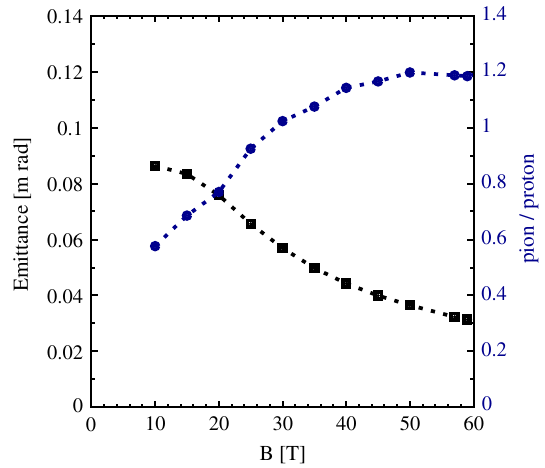
FIG. 5. The transverse emittance of secondary pions at the end of the target is stabilized by the target solenoid field as predicted by the analytic form. The number of captured pions at the end of the target increases with the focusing field strength reaching the maximum at 50